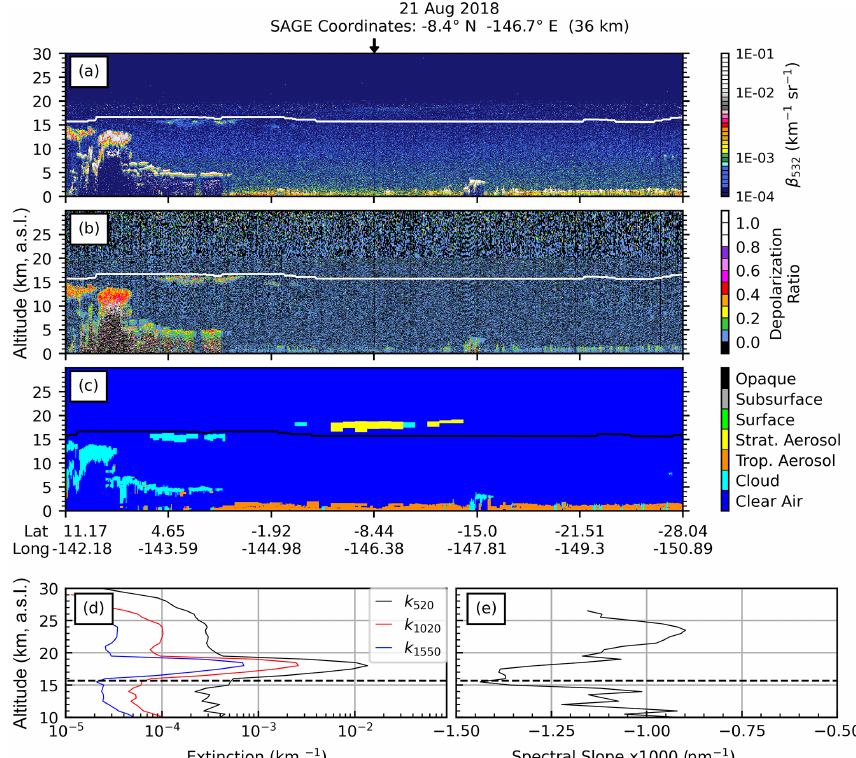
Figure 6. CALIOP and SAGE data collected during the Ambae eruption. The title indicates the SAGE profile date, SAGE overpass co- ordinates, and the distance between the SAGE profile and the nearest CALIOP profile. Panel (a) presents the CALIOP L1 total attenuated backscatter at 532nm, panel (b) presents the CALIOP L1 depolarization ratio, panel (c) presents the CALIOP L2 VFM, panel (d) presents the SAGE extinction coefficient profiles at three wavelengths, and panel (e) presents the spectral slope profile of the SAGE extinction spectrum. The vertical arrow above panel (a) indicates the location of the SAGE profile along the CALIOP flight path. Solid horizontal lines (panels a , b , and c ) and dashed horizontal lines (panels d and e ) indicate tropopause altitude. The CALIOP granule used to generate this image is